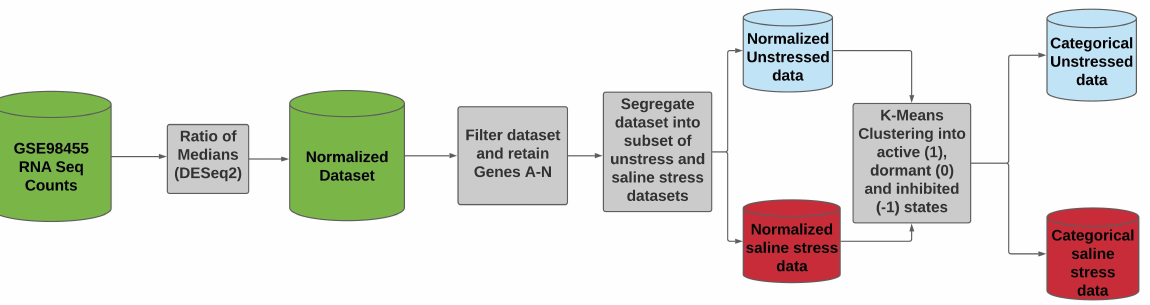
Figure 5. Data processing pipeline for RNA-Seq data set GSE98455.